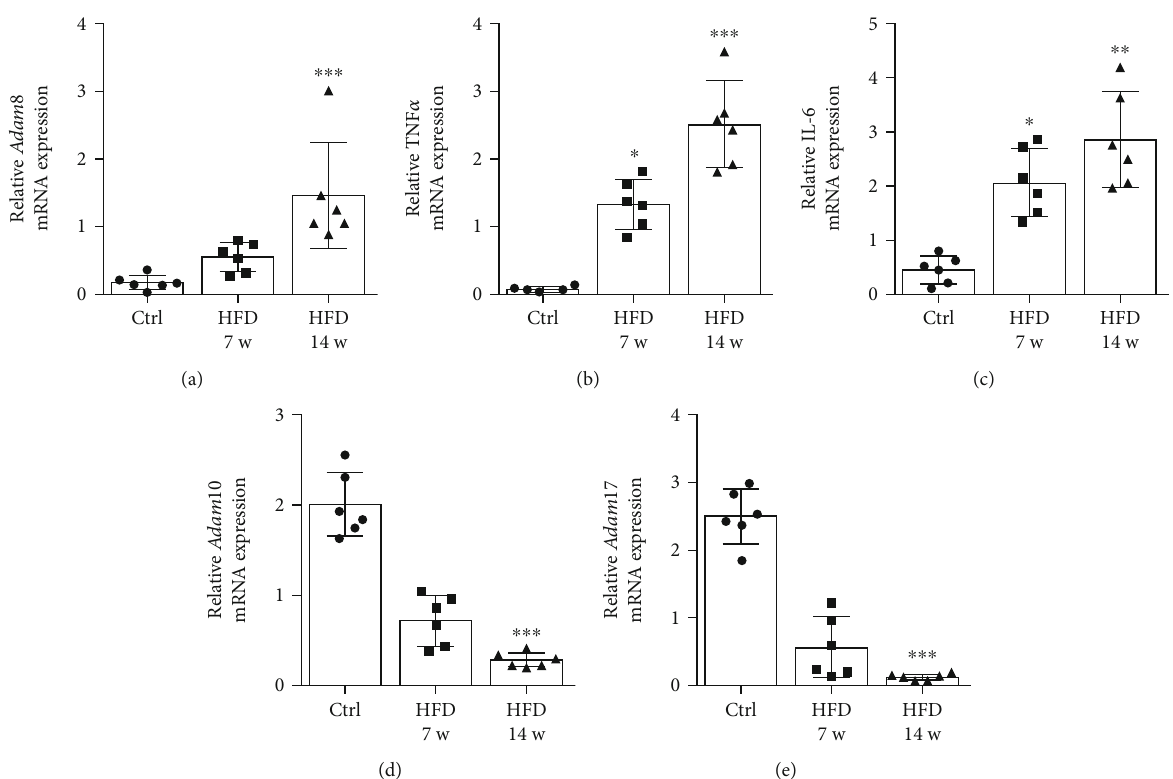
Figure 5: Upregulation of ADAM8 expression in the livers of mice fed on a high-fat diet. (a – e) Relative mRNA expression levels of Adam8 (a), TNF- α (b), IL-6 (c), Adam10 (d), and Adam17 (e) were analysed in the livers of mice that were either fed on a normal diet (Ctrl) or a high- fat diet for 7 weeks (HFD-7w) or 14 weeks (HFD-14w). The mRNA expression of the genes of interest was normalised to the average of three reference genes: 18S , β -actin , and Rps29 . Data are shown as the mean ± SD ( n = 6 /group). Di ff erences to the control group are indicated by asterisks ( ∗ p < 0 : 05 , ∗∗ p < 0 : 01 , and ∗∗∗ p < 0 : 001